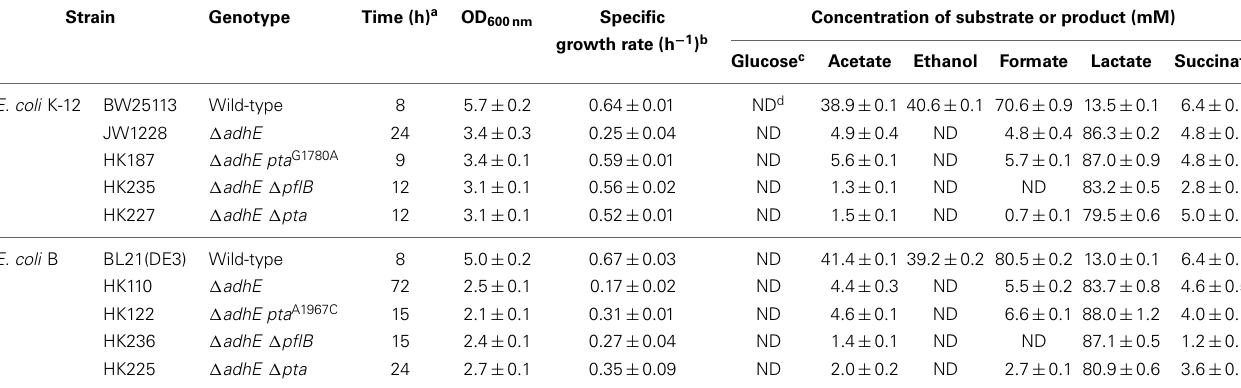
Table 2 | Anaerobic fermentation profiles of wild-type cells and (cid:2) adhE derivatives of E. coli K-12 and B strains.